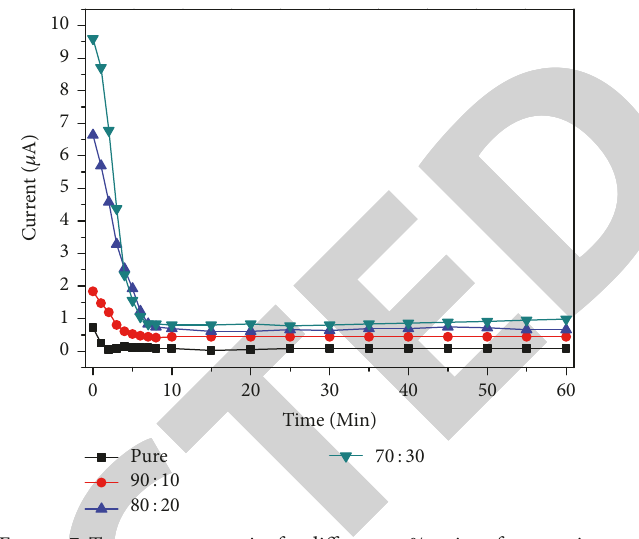
Figure 7: Transport properties for different wt% ratios of composite polymer electrolyte